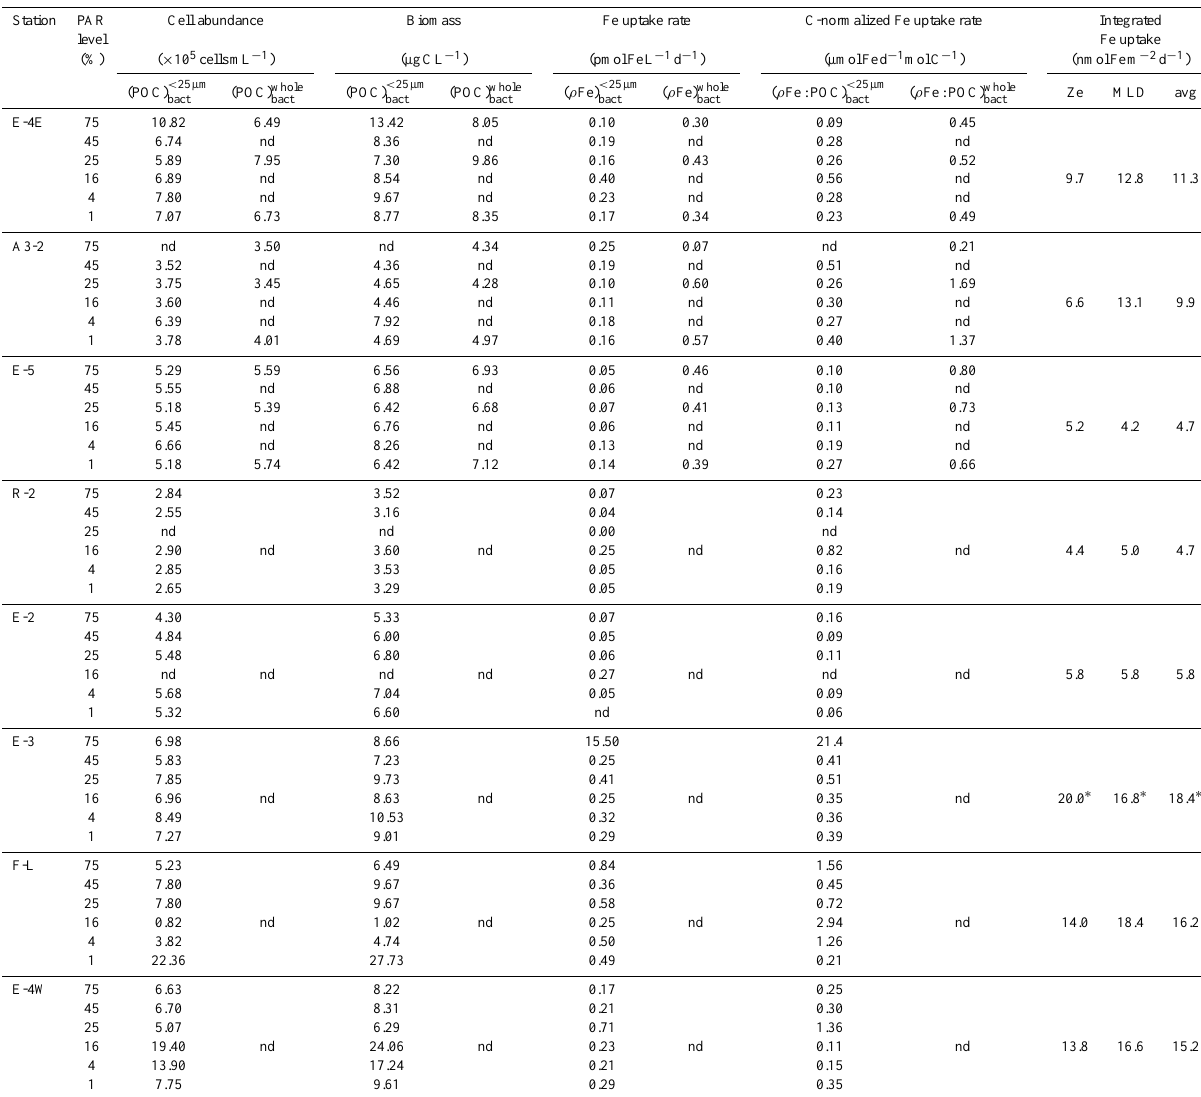
Table 5. Bacterial abundance, C biomass, Fe uptake rates, C-normalized Fe uptake rates and integrated Fe uptake (to the euphotic layer depth, Ze; to the mixed layer depth, MLD; average, avg). Values given in the columns (POC) < 25µm relative to incubations with bacteria and pico-nanoplankton only. Values given in the columns (POC) whole are relative to incubations performed with the bulk community. Integrated values are calculated from incubations with bacteria and pico- nanoplankton only. nd: no data available. Cell numbers refer to the end of the incubation time (24h). Station